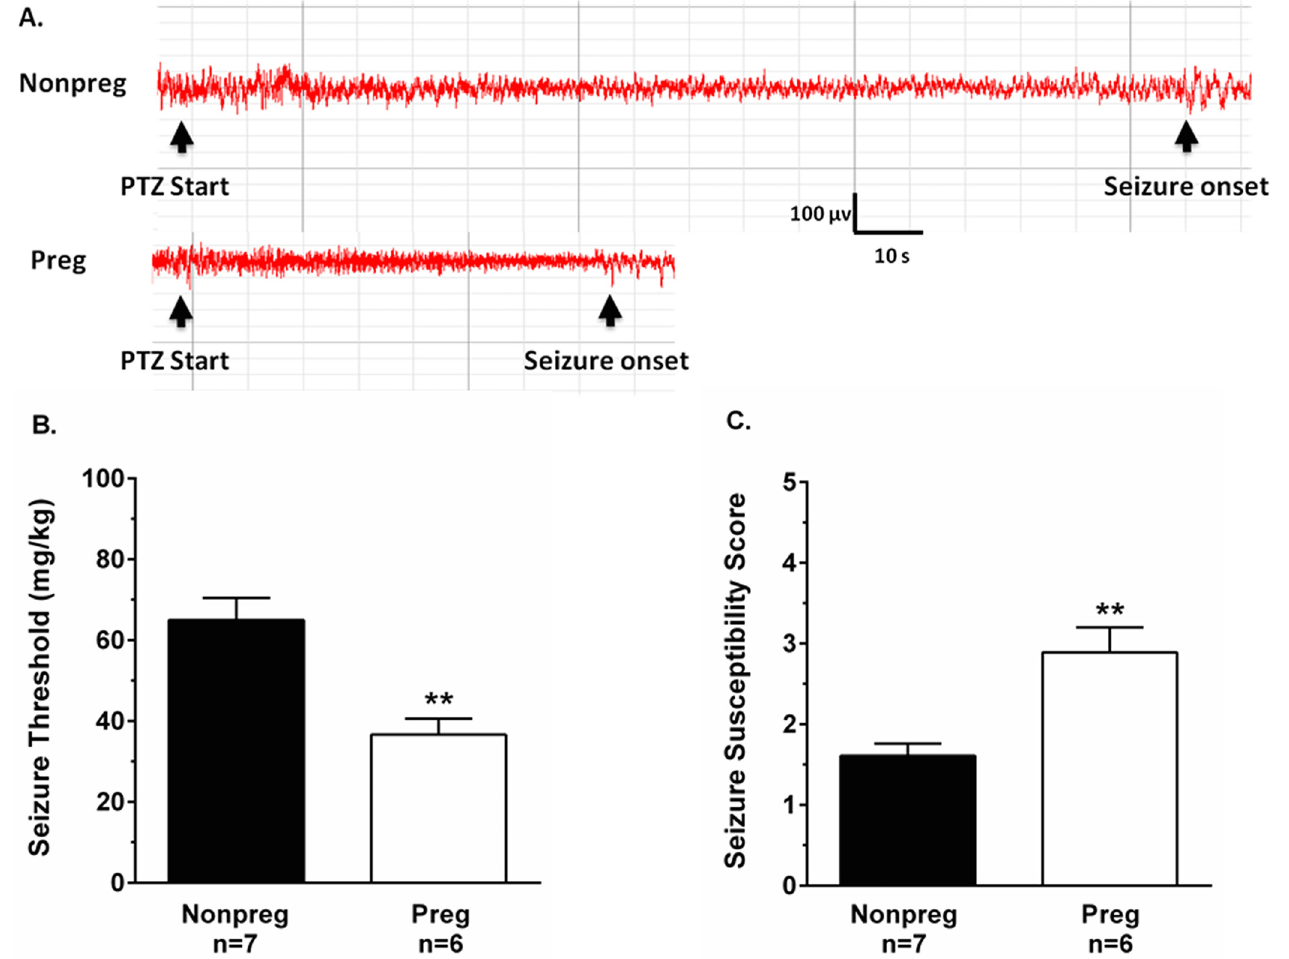
Fig 1. The effect of normal pregnancy on seizure threshold and susceptibility. (A) Representative EEG tracings from nonpregnant (Nonpreg) and late- pregnant (Preg) rats during timed-infusion of pentylenetetrazol (PTZ). Black arrows indicate when PTZ infusion started and the onset of spike-wave discharge indicative of electrical seizure. (B) Seizure threshold was significantly lower in Preg rats compared to Nonpreg rats. (C) Preg rats scored higher on the seizure susceptibility scale compared to Nonpreg rats. ** p < 0.01 vs. Nonpreg by Student ’ s t-test.